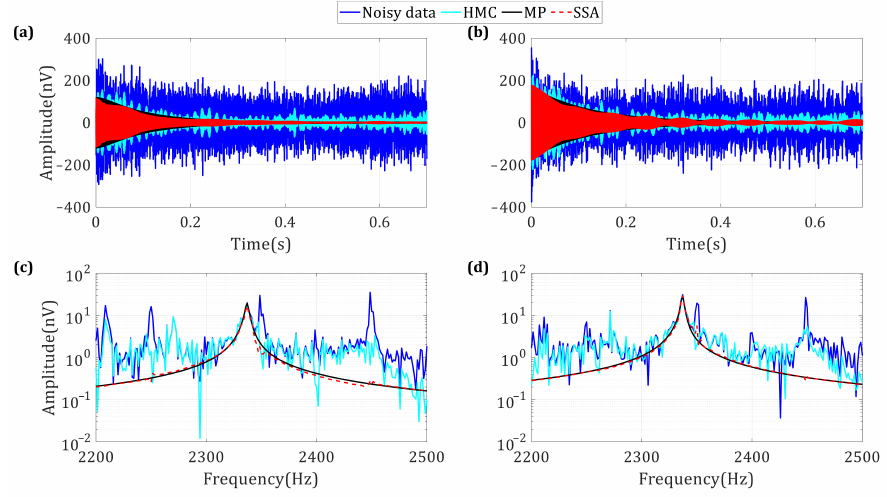
Figure 8. Processing results of field-measured data: ( a ) the results processing with the MP, HMC, and SSA algorithms under the fifth pulse moment and the time domain waveform of SNR = − 8.42 dB data, with ( c ) the corresponding spectrum, and ( b ) under the seventh pulse moment and the time domain waveform of SNR = − 4.71 dB data, with ( d ) the corresponding